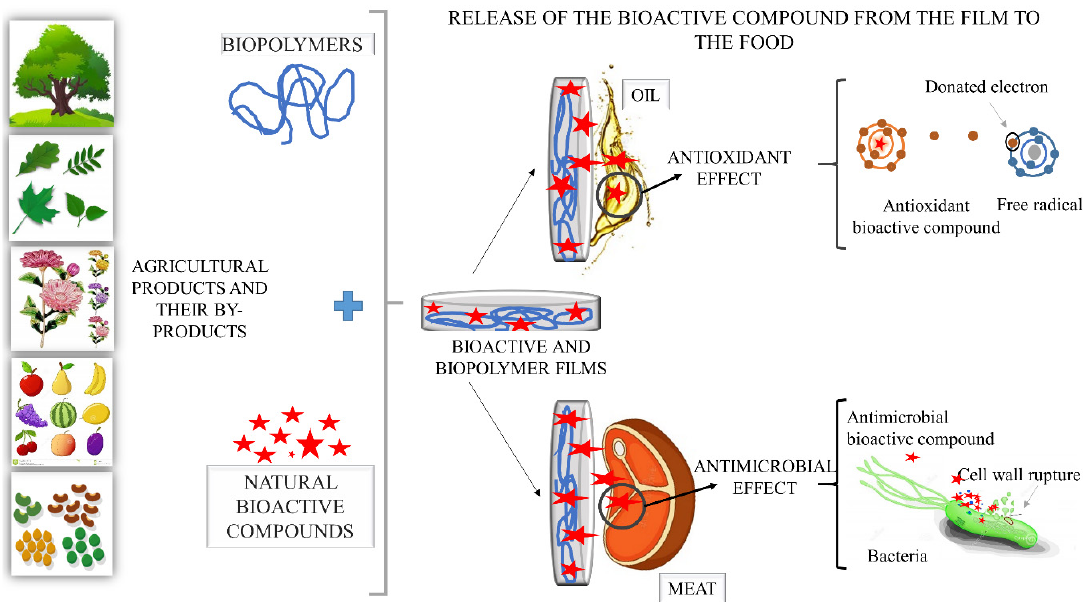
Figure 4. Illustration of the bioactive properties of films from agro-based polymers and incorporated with plant-derived bioactive compounds.